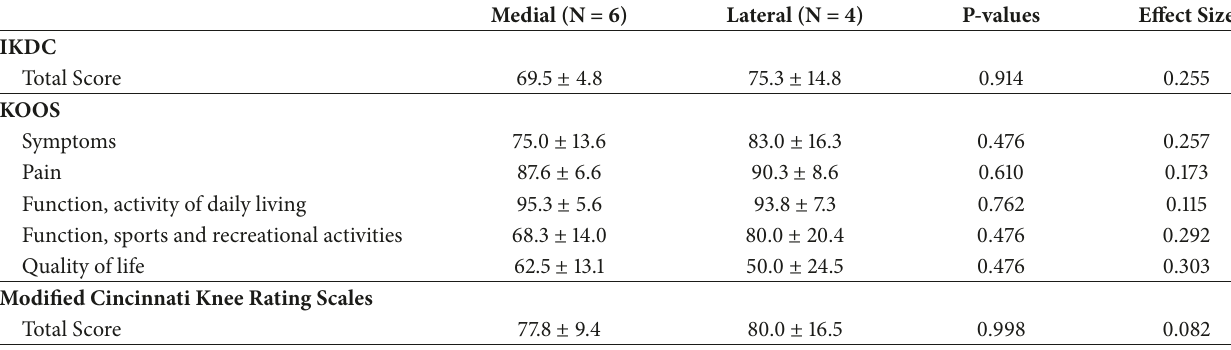
Table 6: Comparison of the patients’ reported outcome scores by OCD location.